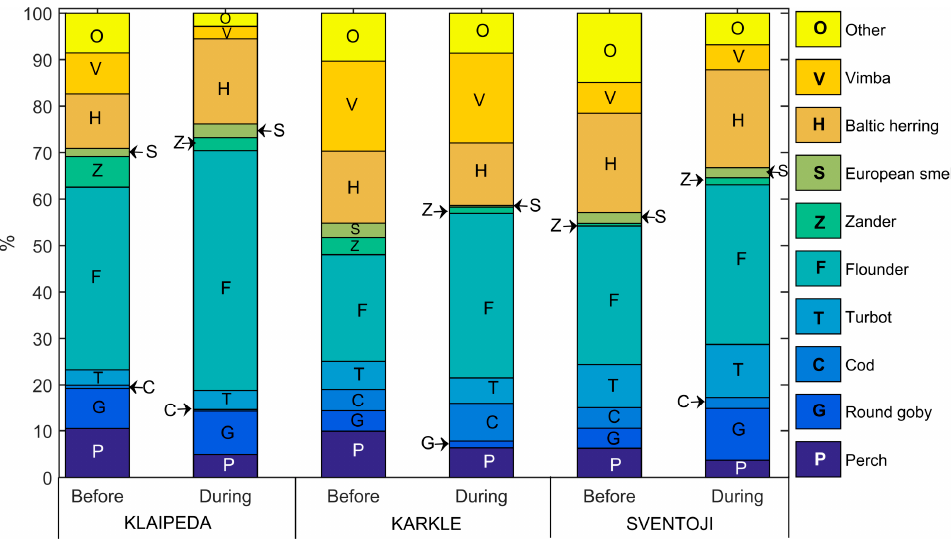
Figure 3. Fish assemblage structure before and during upwelling in three sampling locations.